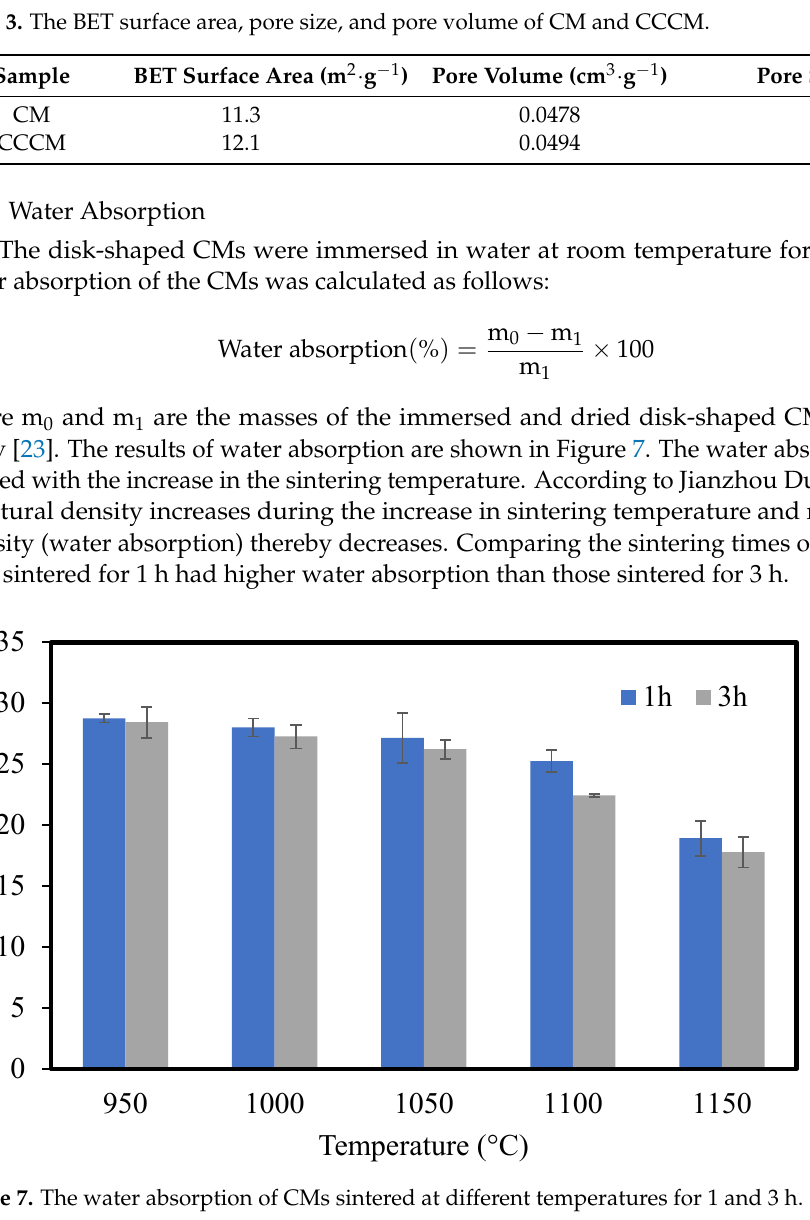
Figure 7. The water absorption of CMs sintered at different temperatures for 1 and 3 h.